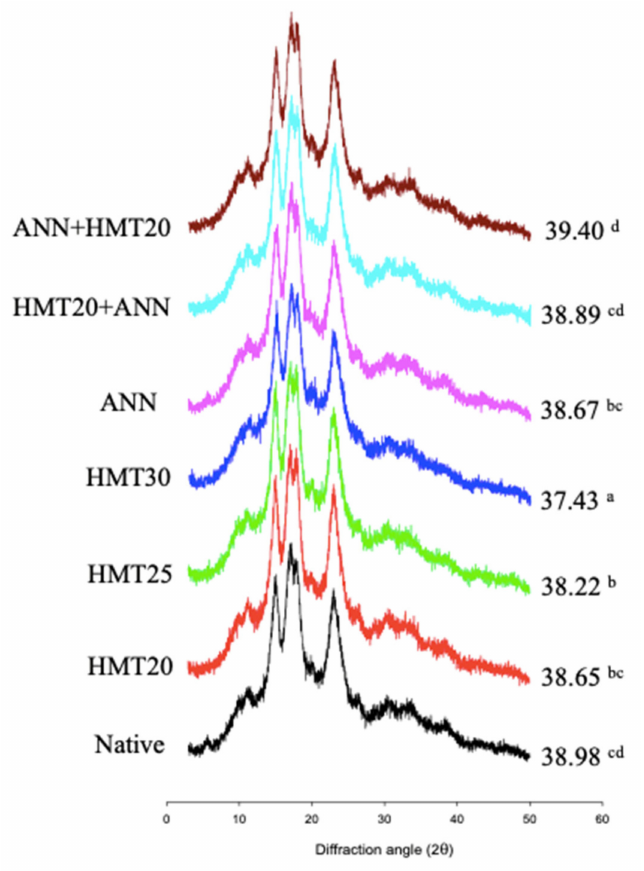
Figure 4. Effect of various hydrothermal treatments on the X-ray diffraction patterns and relative crystallinity of water caltrop starches. Sample codes refer to Figure 1. a–d Relative crystallinity values with different letters are significantly different ( p <